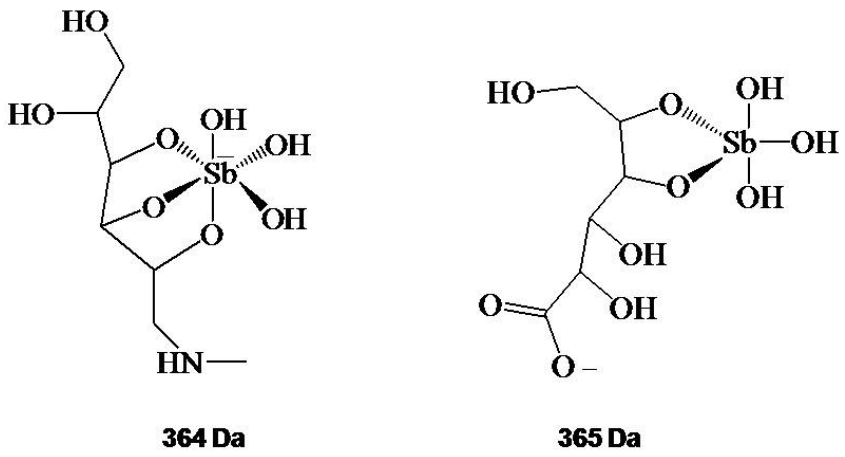
Figure 1. Proposed structural formula for 364 Da and 365 Da ions identified by ESI(-)-MS in aqueous solutions of meglumine antimoniate and stibogluconate, respectively. Adapted from Ref.